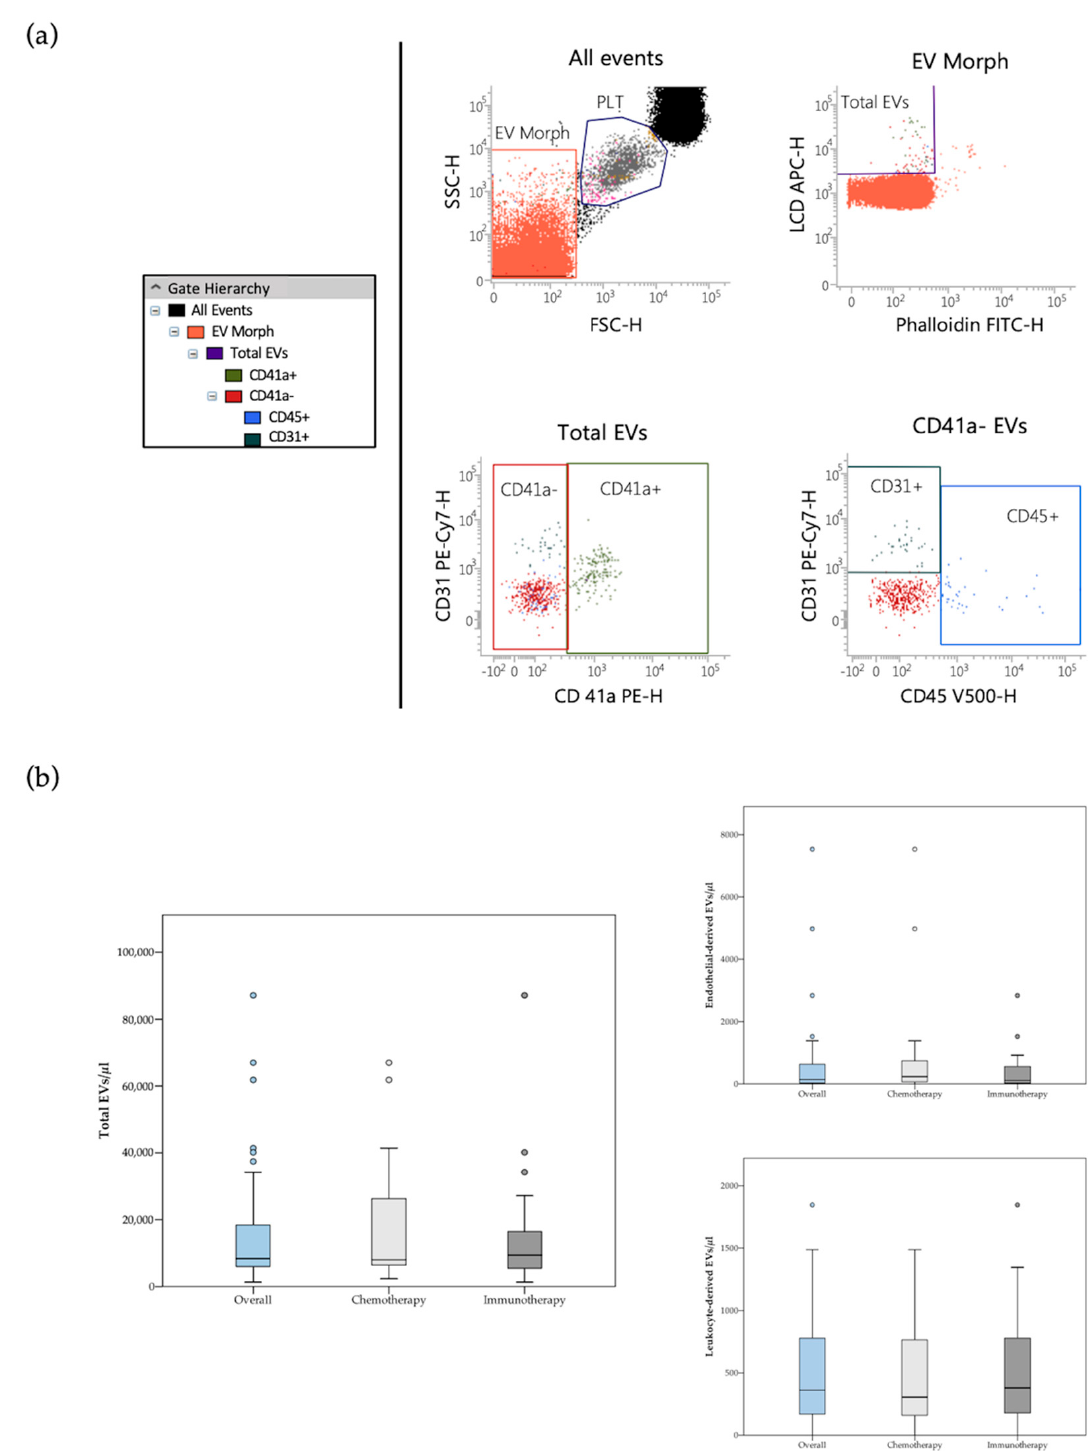
Figure 1. ( a ) Flow cytometry identification of total EVs, leukocyte-derived (CD45+ events) and endothelial-derived (CD41a − /CD31+/CD45 − events) EVs in peripheral blood samples. The hierarchy of the gating strategy is represented. ( b ) Box plot diagram showing median blood concentration before treatment (horizontal black lines) of total EVs and EV subtypes in the overall population and in the two study groups. Extreme values are not